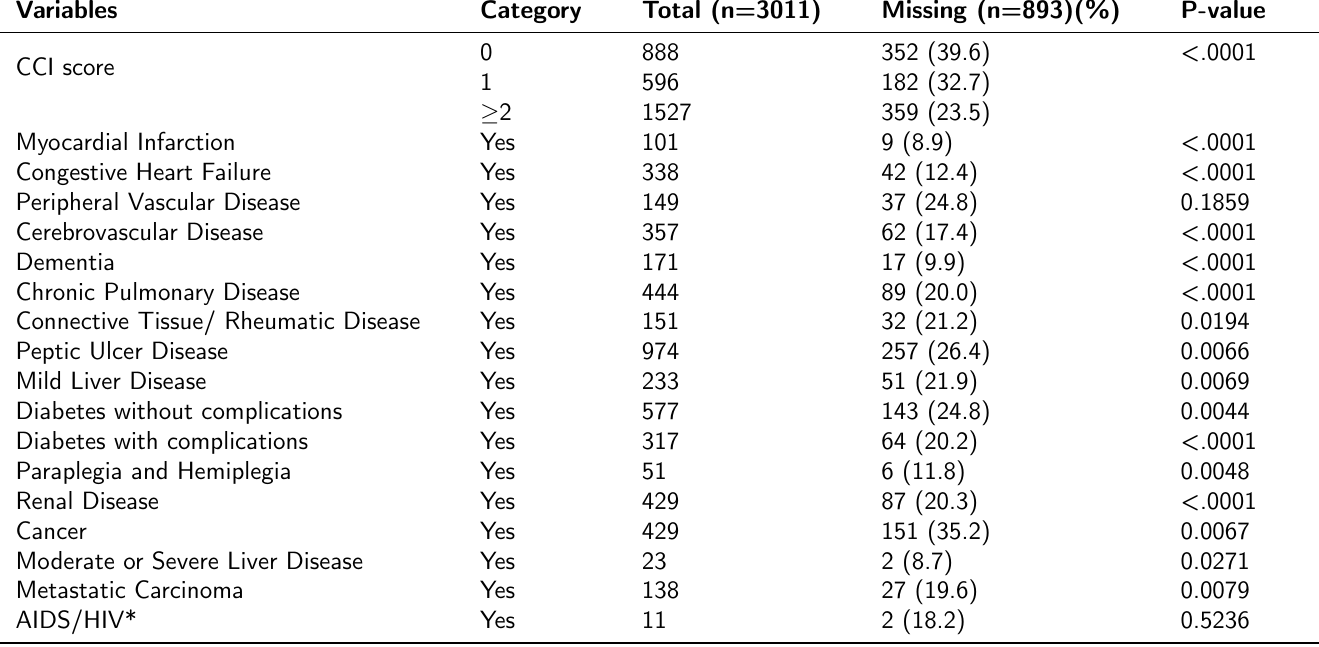
Table 2: Frequencies of comorbidities assessed for association with missing discharge summaries in the EMR Variables